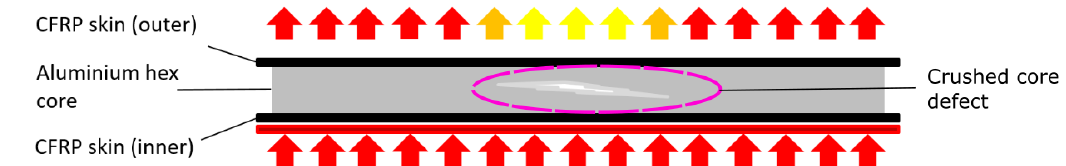
Figure 1. Transmission thermography basic principle of defect detection through detection of thermal transfer changes. Thermal energy shown in red arrows ( bottom ); the resultant thermal energy due to thermal conduction shown in the red to yellow arrows ( top ) displays a reduction in thermal energy over the defect area within the Aluminium core.